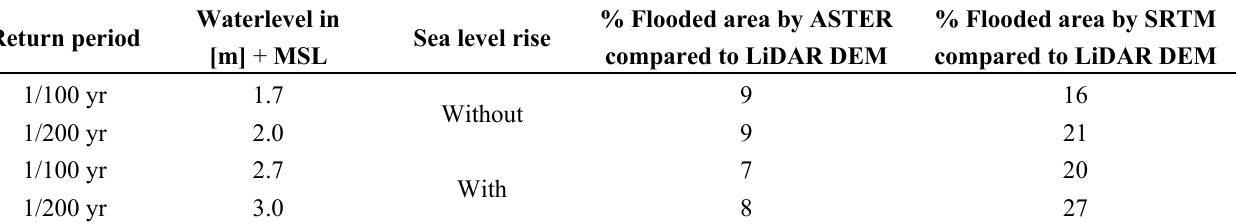
Table 3. Percentages of ASTER GDEM and SRTM DEM of flooded areas compared to LiDAR DEM. Waterlevel in % Flooded area by ASTER % Flooded area by SRTM Return period Sea level rise [m] + MSL compared to LiDAR DEM compared to LiDAR DEM 1/100 yr 1.7 9 16 Without 1/200 yr 2.0 9 21 1/100 yr 2.7 7 20 With 3.0 8